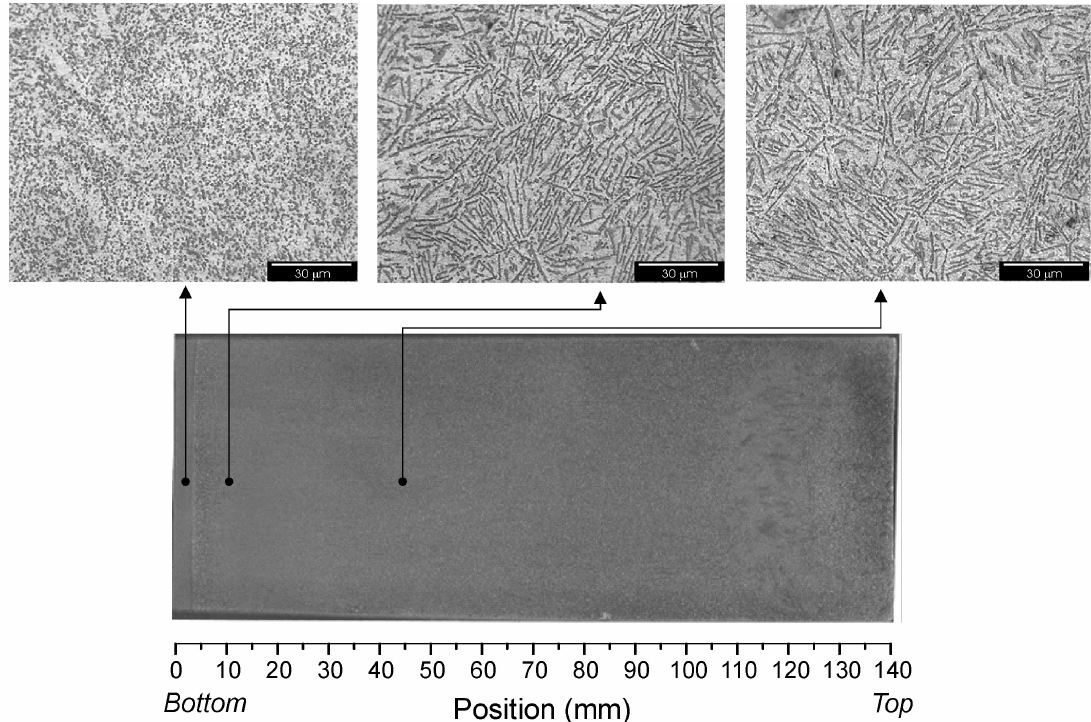
Figure 1. Directionally solidified macrograph of the Al-15 wt.%Si-1.0 wt.%Bi alloy with light micrographs related to specific positions along its